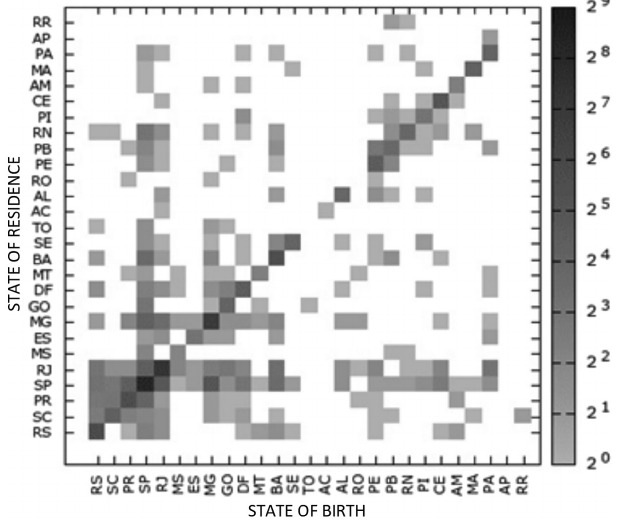
FIG. 1. Current state of residence versus state of birth. The gray scale represents the number of individuals. Brazilian states (two letter code) were ordered by latitude of their capital. From the respondents, 1594 are Brazilian and 1659 live in